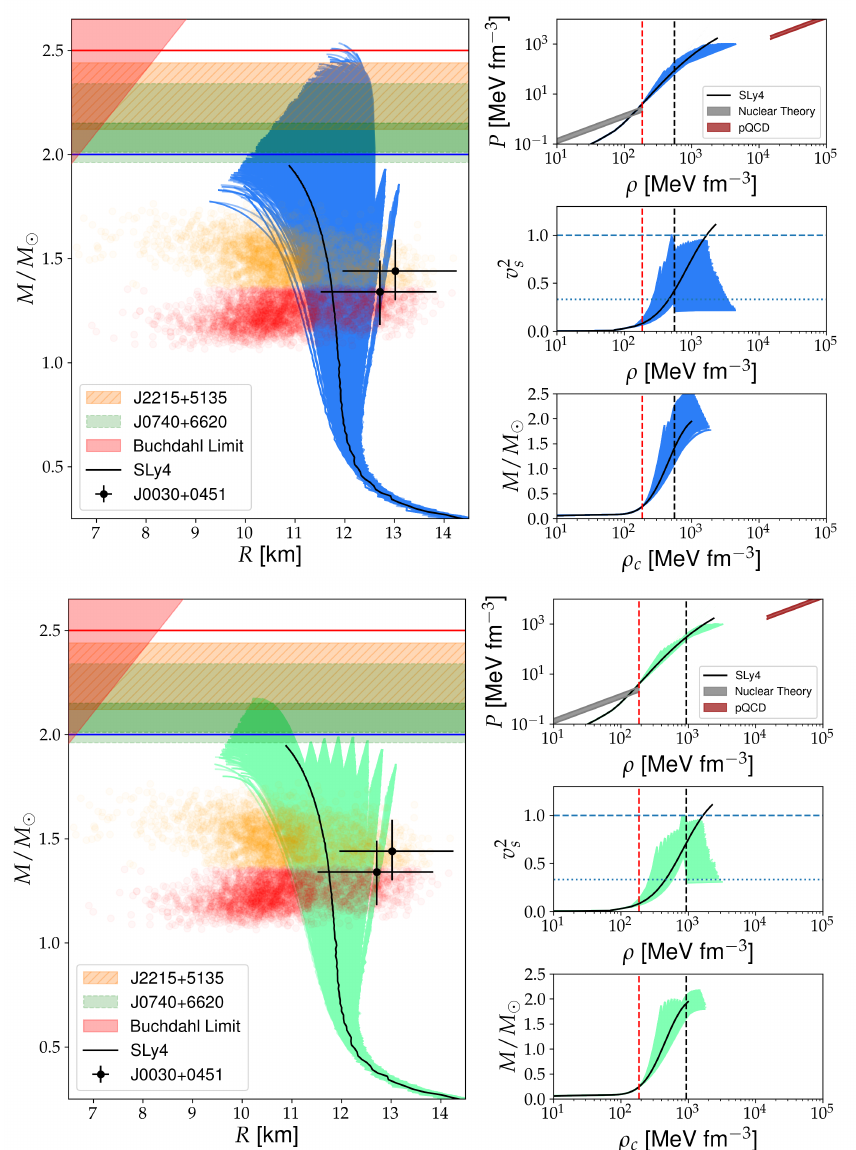
Figure 5. Same as Figure 4: in the upper panel, the blue one, the transition regions are ρ 1 = ρ 0 and ρ 2 = 3 ρ 0 , and, in the lower, the green one, ρ 1 = ρ 0 and ρ 2 = 5 ρ 0